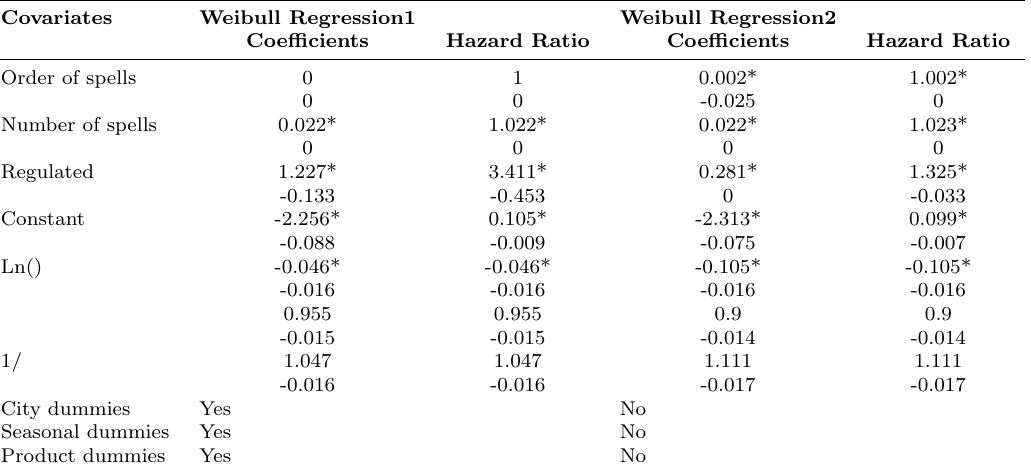
Table 4: Estimation Results of Semi-parametric and Parametric Models Covariates